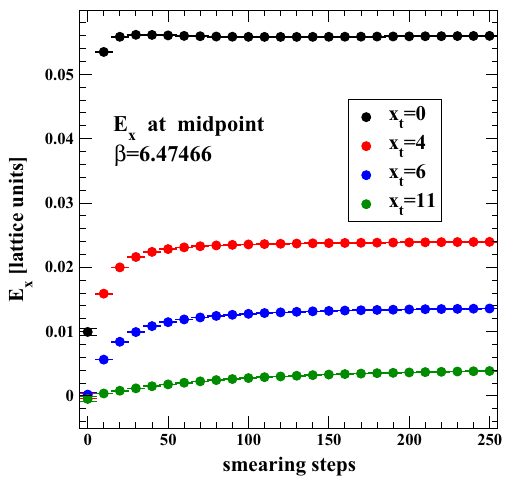
Fig. 7 E x in lattice units at several values of x t versus smearing at β = 6 . 47466 and d = 8 a (cid:9) 0 . 37 fm as in Ref. [36]